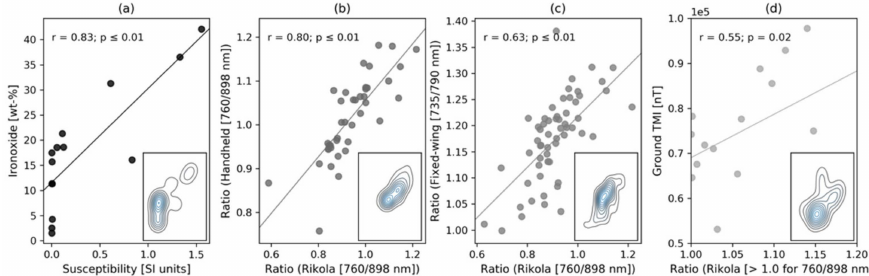
Figure 15. Scatter plots showing the relationships of di ff erent scanning methods from the outcrop, point pairs on the same location, or from the same pixel. The Pearson correlation r and significance p are given for each pair. ( a ) Correlation plot for handheld magnetic susceptibility vs. pXRF iron-oxide. ( b ) Correlation for UAS Rikola iron band ratio (760 / 898 nm) vs. handheld iron band ratio (760 / 898 nm). ( c ) Correlation for UAS Rikola iron band ratio (760 / 898 nm) vs. fixed-wing eBee iron band ratio (735 / 790 nm). ( d ) Correlation of Rikola iron band ratio (760 / 898 nm) vs. ground TMI. The inset plot in each bottom-right corner distributes the kernel density per variable